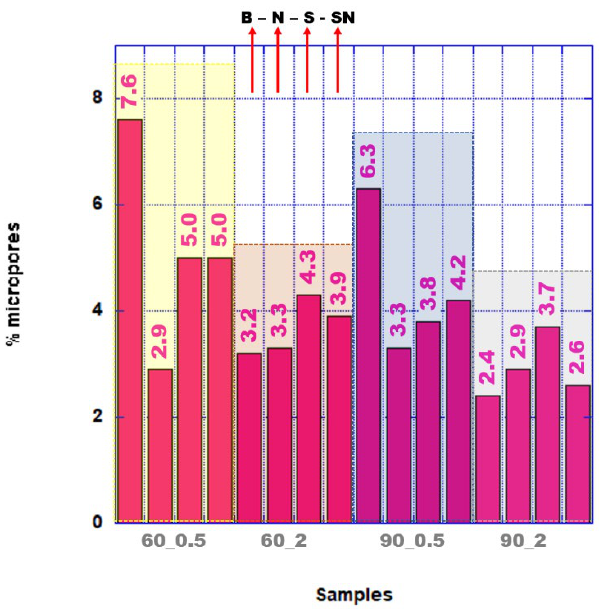
Figure 6. Micropores percentage for all samples and for all preparation parameters and modifications. Labels of B, N, S, and SN represent the blank system, systems modified with TMON, systems modified with TMOS, and systems modified with TMOSN, respectively.